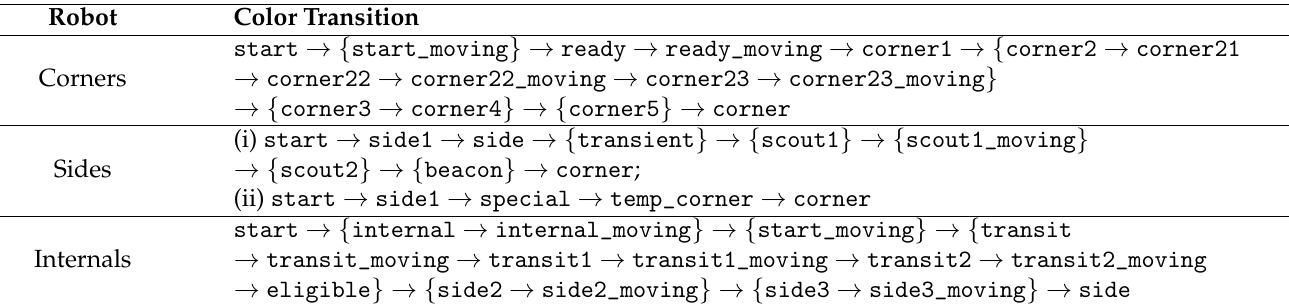
Table 2. Color transitions of the robots during the execution of the algorithm. A color inside {} indicates that not all corners (sides or internals) may assume that color during the execution.